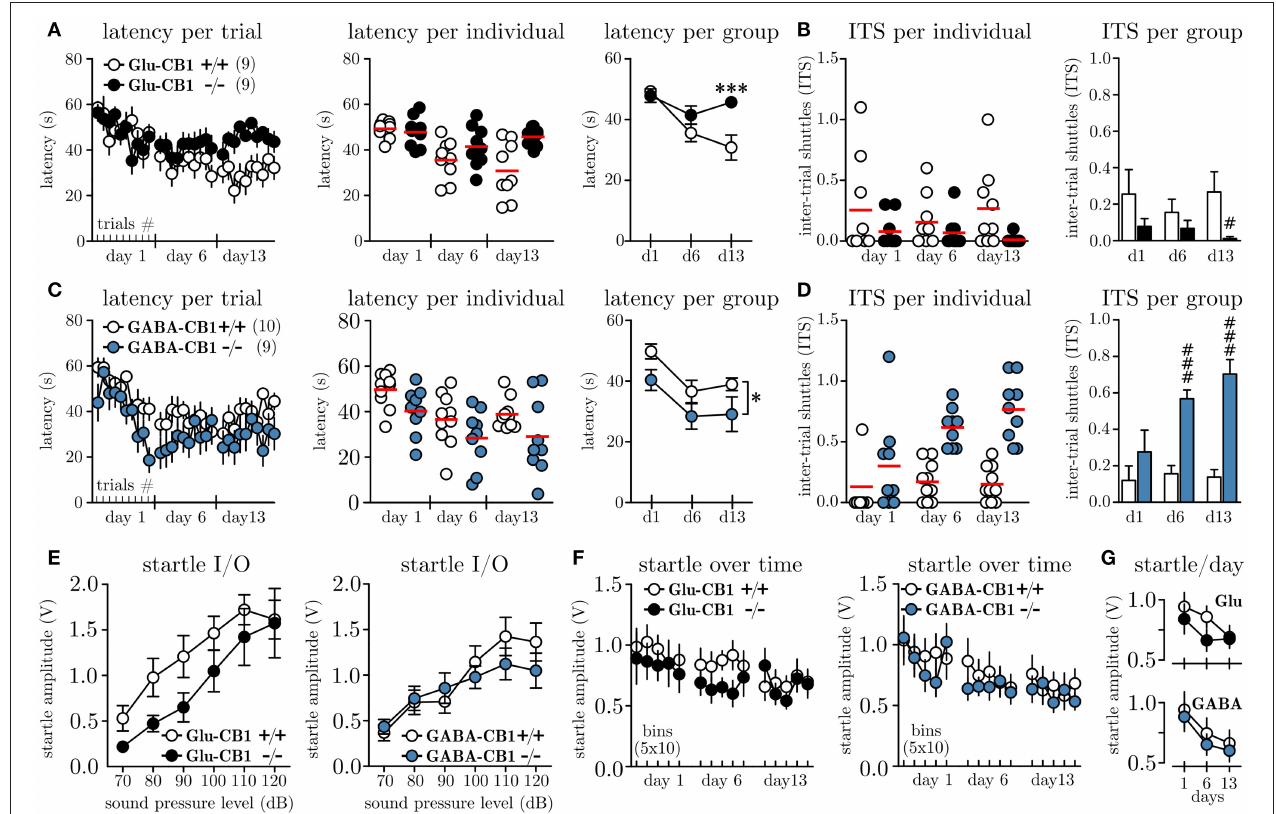
FIGURE 2 | Conditional knock-out of CB1 on glutamatergic vs. GABAergic neurons differentially affects escape behavior. (A) Latencies to shuttle to the opposite compartment during the MWB task, given per trial ( left panel ), per individual and day ( mid panel ) and per group and day ( right panel ) for Glu-CB1 + / + ( N = 9) and Glu-CB1 − / − ( N = 9). (B) Inter-trial shuttles per individual and day ( left panel ) and per group and day ( right panel ) for Glu-CB1 + / + and Glu-CB1 − / − . (C) Latencies to shuttle to the opposite compartment during the MWB task, given per trial ( left panel ), per individual and day ( mid panel ) and per group and day ( right panel ) for GABA-CB1 + / + ( N = 10) and GABA-CB1 − / − ( N = 9). (D) Inter-trial shuttles per individual and day ( left panel ) and per group and day ( right panel ) for GABA-CB1 + / + and GABA-CB1 − / − . (E) Startle input-output (I/O) curves for Glu-CB1 and GABA-CB1 animals. (F) Startle response at SPL 50 development over time depicted in bins of 10 trials. (G) Same data as in (F) but shown as average startle amplitude at SPL 50 per day for the individual groups for ( upper panel ) Glu-CB1 + / + (empty circles) and Glu-CB1 − / − (filled circles) animals and ( lower panel ) GABA-CB1 + / + (empty circles) and GABA-CB1 − / − (filled circles) animals. Asterisks indicate significance values obtained by repeated measures two-way ANOVA followed by Bonferroni post-hoc test: * p < 0.05, *** p < 0.001. Hashes indicate significance values obtained by Mann-Whitney U -tests: # p < 0.05, ### p < 0.001. All values are given as mean ± SEM. Red bars in individual data represent the mean